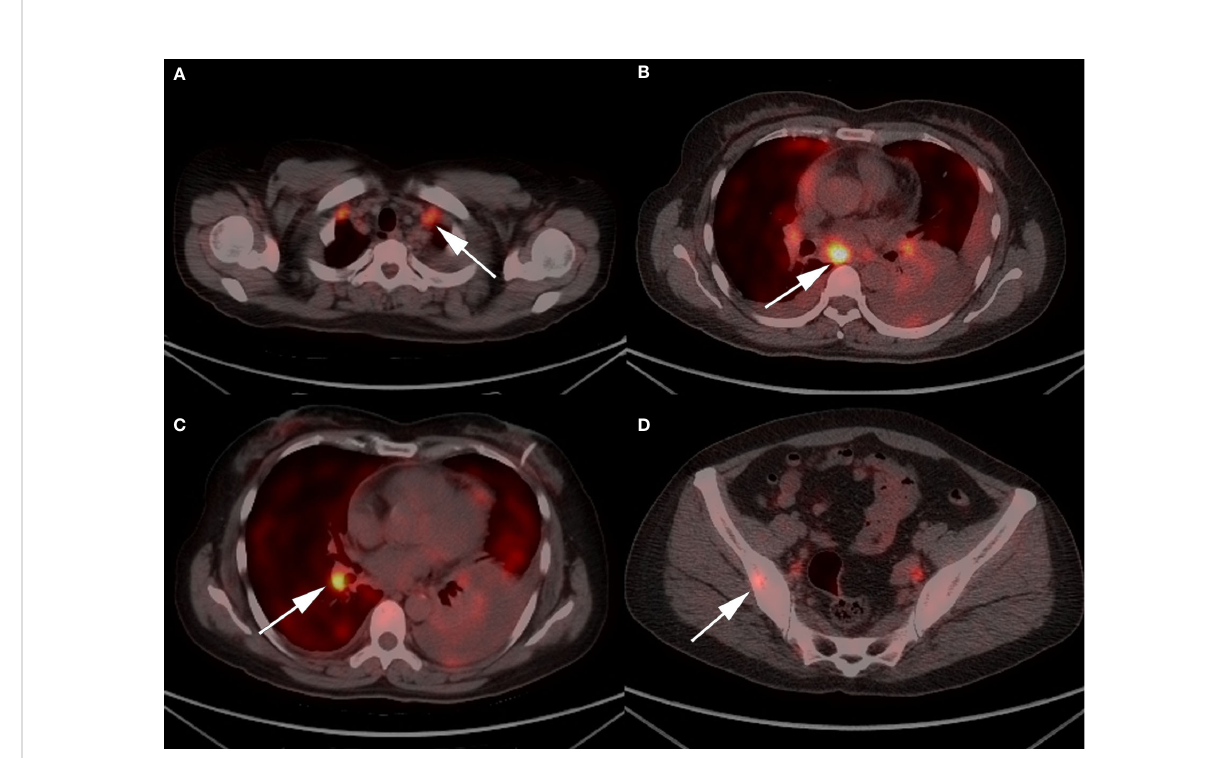
FIGURE 1 Representative 18 F/FDG PET-CT images of the patient: (A) enlarged bilateral supraclavicular and (B) mediastinal lymph nodes; (C) a 3.4*2.4 cm soft tissue density mass in the right lower lobe; and (D) increased metabolism in right